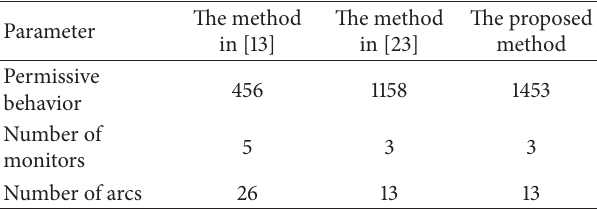
Table 4: The performance comparison of supervisors for the S 4 PR in Figure 2 due to different policies.